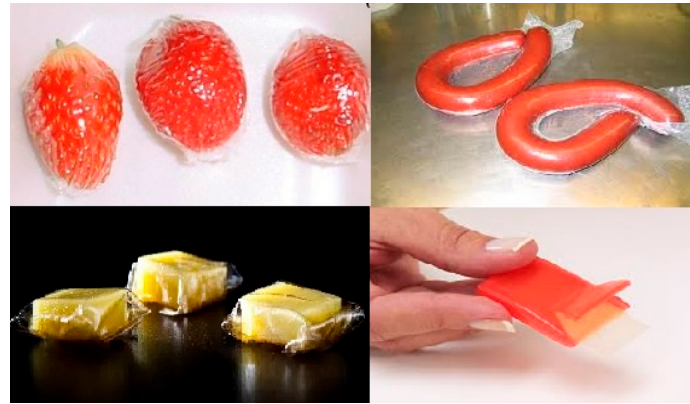
Figure 2. Some examples of edible films in the food packaging industry.